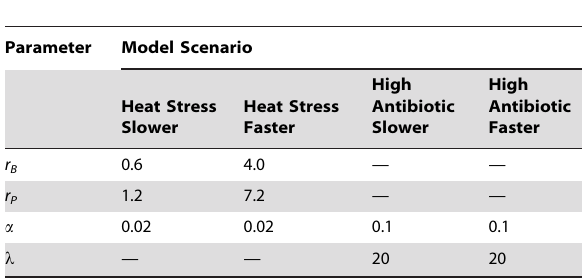
Table 2. Default parameter values for the heat stress and high antibiotic scenarios in the sensitivity analysis of the spatial